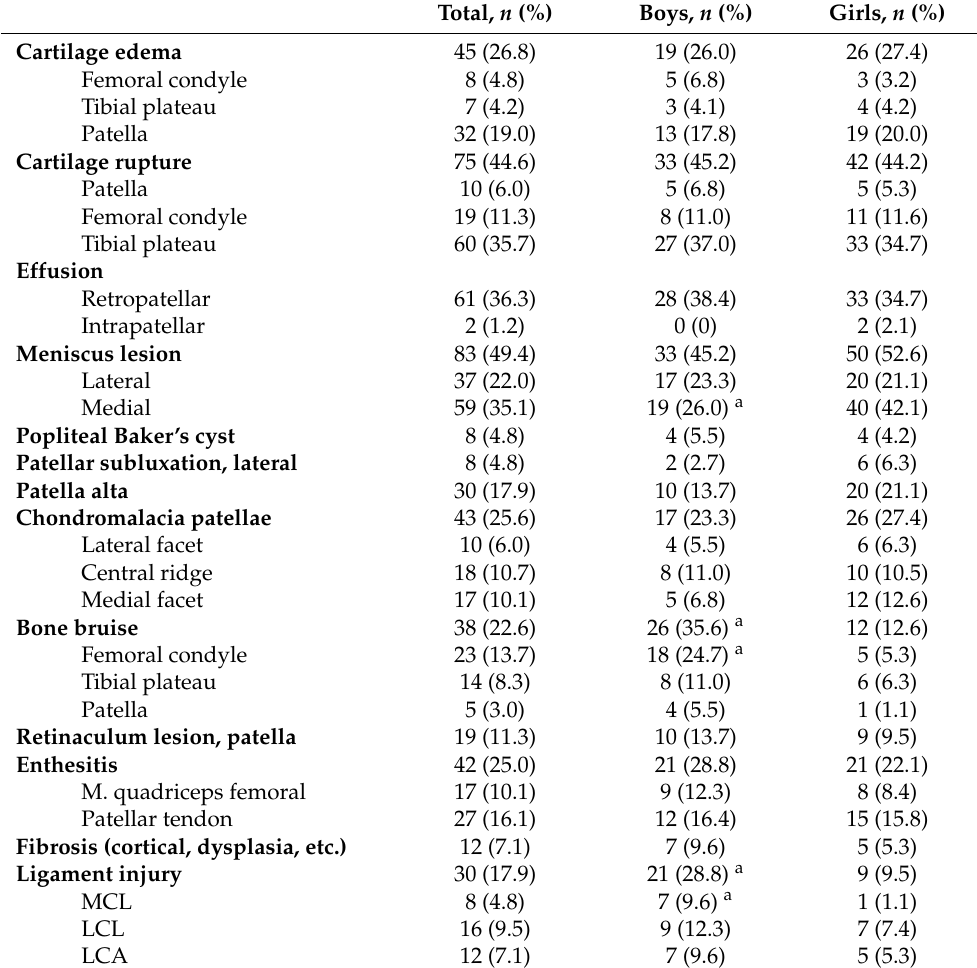
Table 2. Morphological substrates detected on MRI in pediatric patients with knee overuse syndrome, overall and gender-related